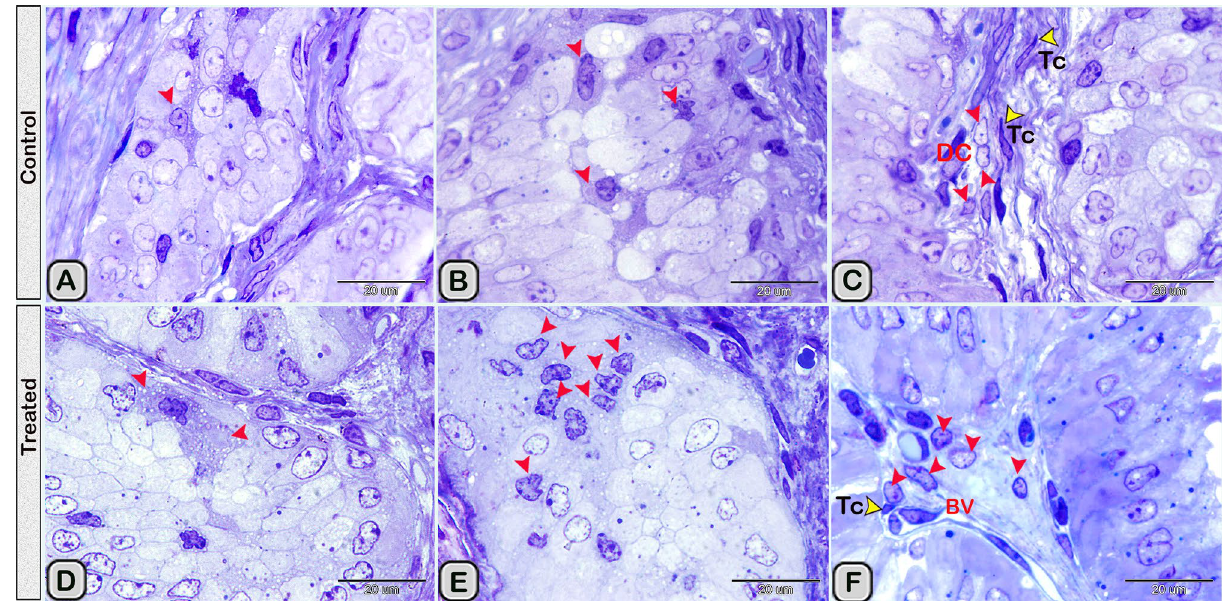
Figure 3. (A,B) The free movable DCs (red arrowheads) were observed within the glandular epithelium lining the seminal gland of the control groups. (C) Interstitial DCs (red arrowheads) were observed in a close contact to telocytes (TC, yellow arrowheads). ( D–F ) Semi-thin sections stained with Toluidine blue in the melatonin treated groups. (D,E) free movable dendritic cells were larger in size and more abundant in comparison to the control ones (red arrowheads). (F) Interstitial DCs (red arrowheads) were more abundant compared to the control group and in a close contact to telocytes (TC) and blood vessels